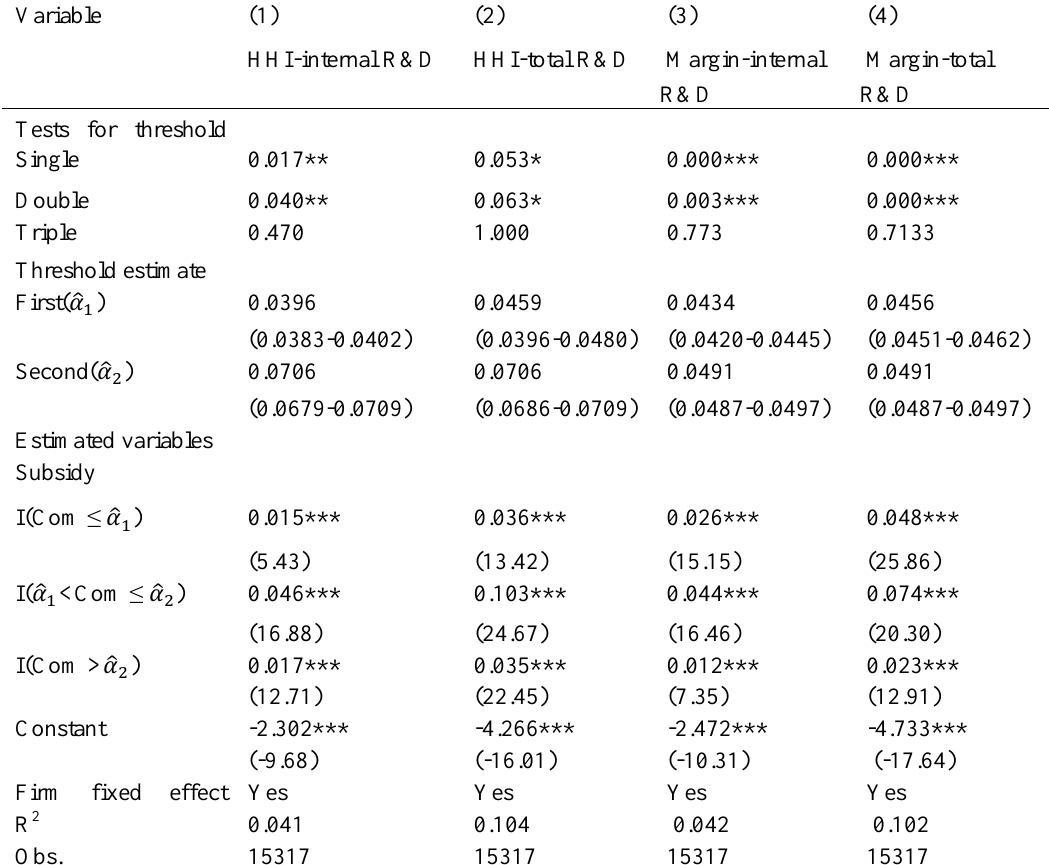
Table 5 : Other R&D subsidy proxies: the industry mean of the R&D